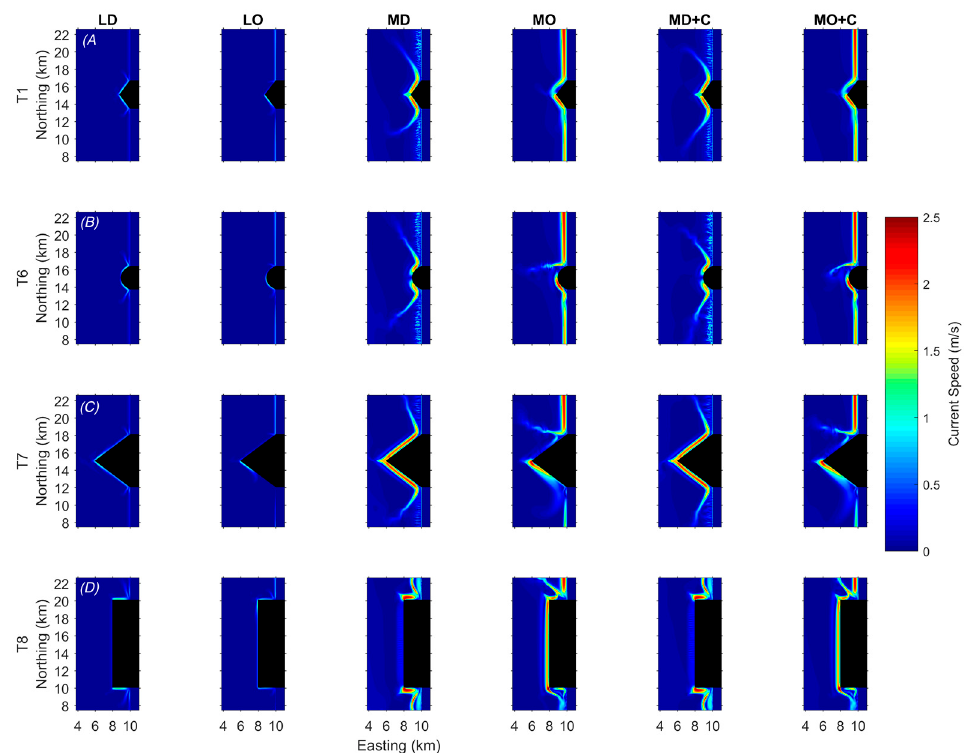
Figure 5. Model results of current speed for waves only and for waves with a regional current forcing during the fastest velocity timestep where L = least wave power, M = most wave power, D = direct wave angle, O = oblique wave angle, and C = regional current. Row A is Headland T1, Row B is T6, Row C is T7, and Row D is T8.